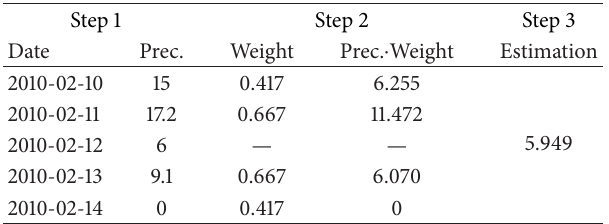
Table 7: Example calculation to interpolate for missing precipita- tion.